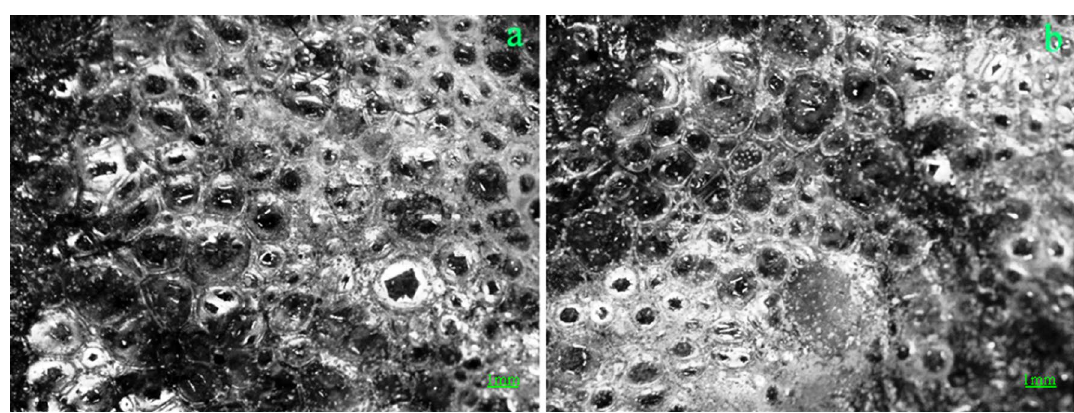
Figure 4. The polymer adhesive membrane on the surface of soil column.